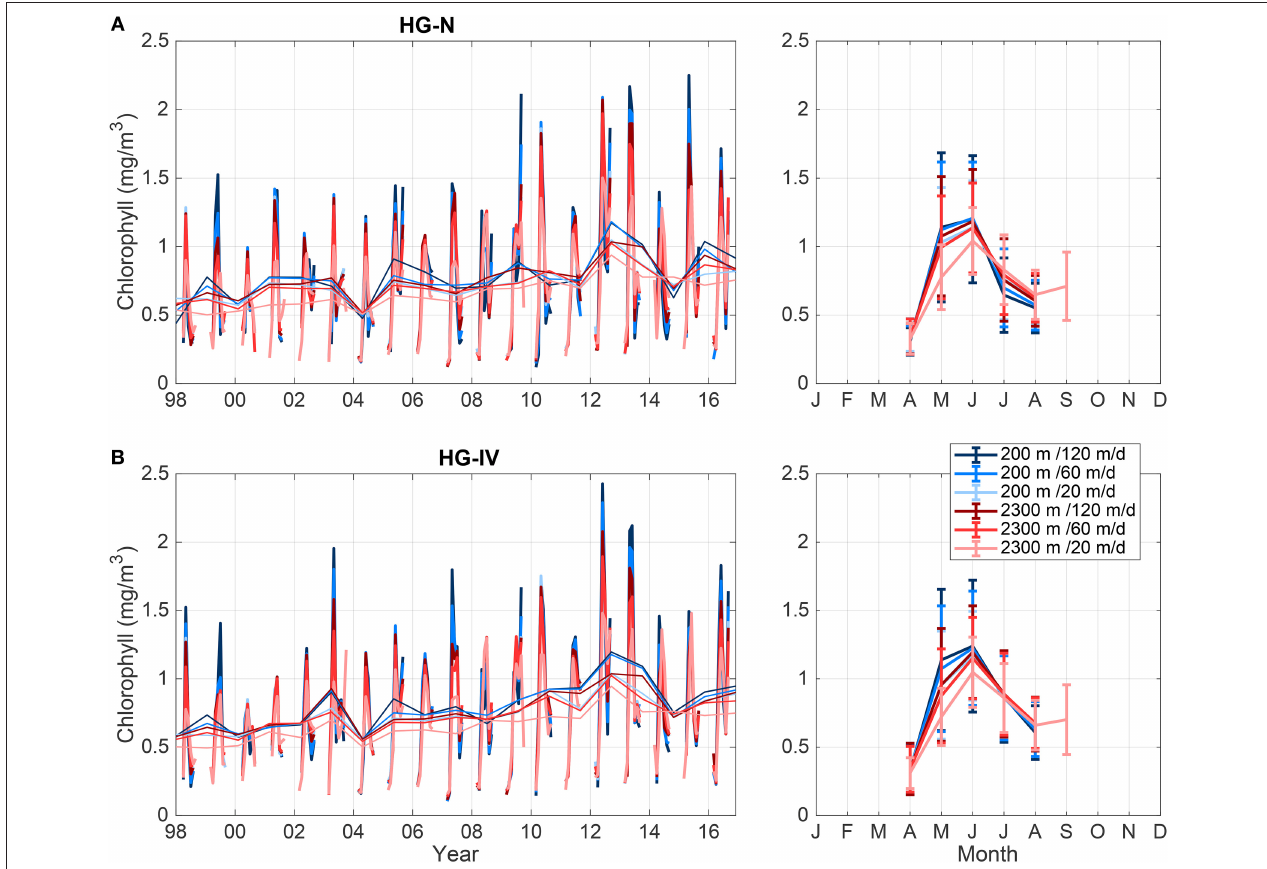
FIGURE 6 | Monthly mean (thick lines) and summer mean (thin lines) chlorophyll-a distribution of the catchment area (mg m − 3 ) of sediment traps (A) HG-N and (B) HG-IV for the time period 1998–2016 (left) and its seasonal cycle (right). Error bars in the right panel show the standard deviation of the monthly mean values. Note that data coverage is limited to the summer